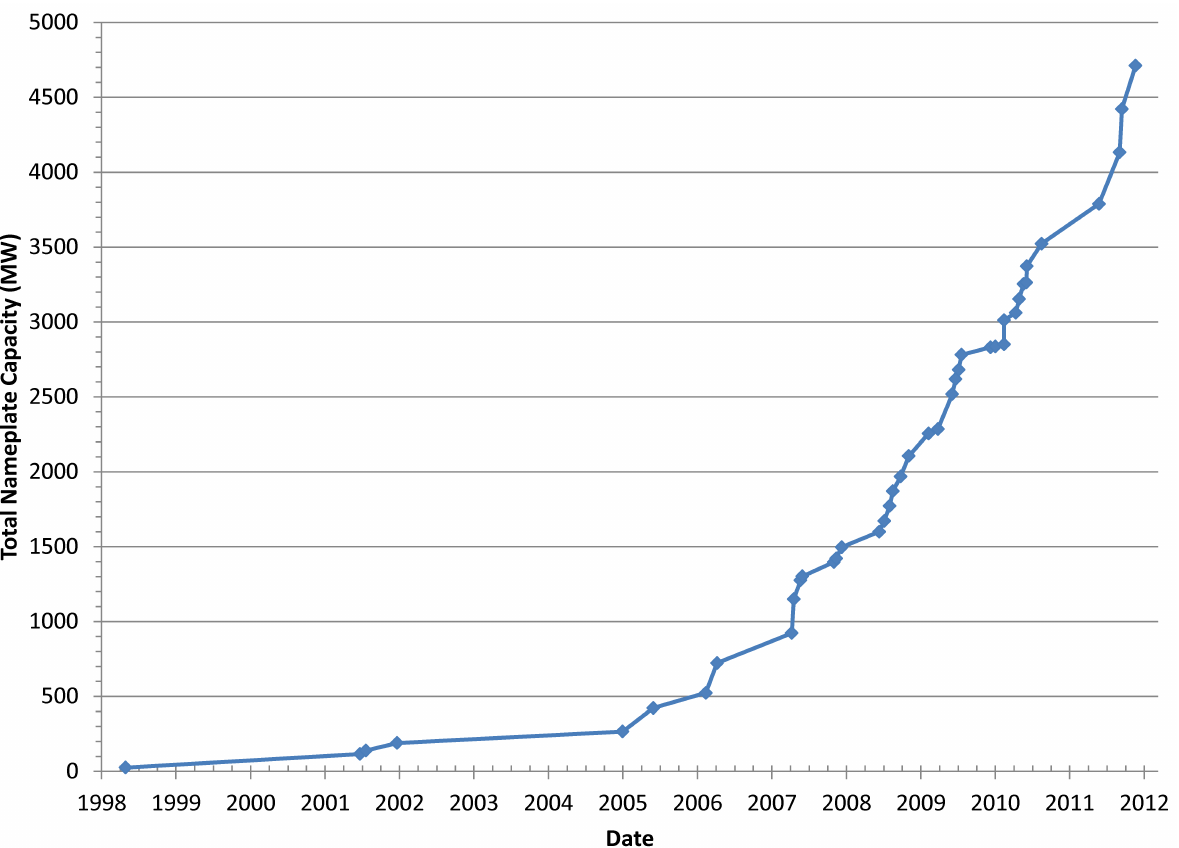
Figure 1. Cumulative nameplate rating of the installed wind capacity in the US Pacific Northwest from 1998 to 2012